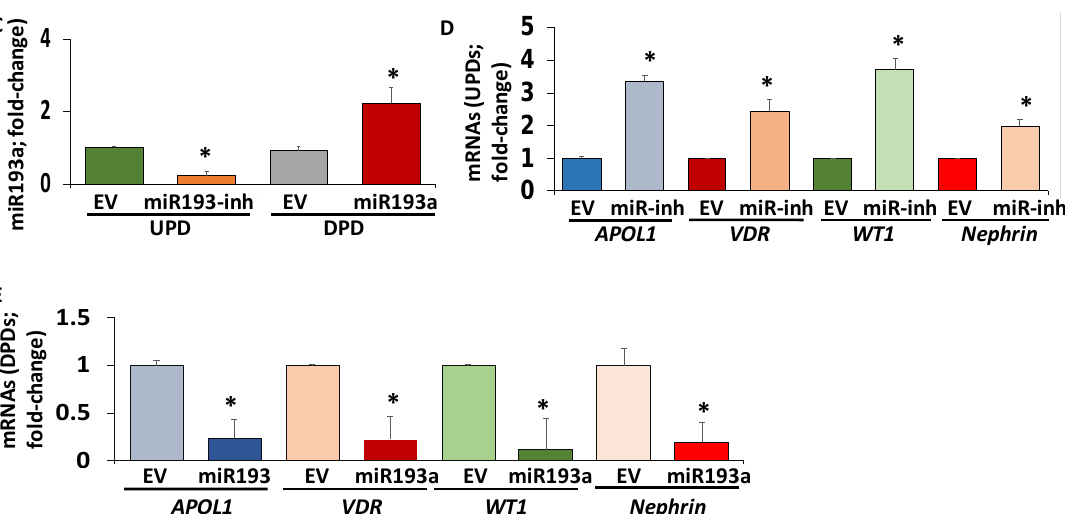
Figure 7. APOL1 3′ UTR and miR193a Secondary structures. ( A ) miR193a-5p structure conformation and hybrid structure conformations of APOL1 3′ UTR and miR193a-5p. The APOL1 3’ UTR structure conformation consists of secondary structure elements such as External loop, Helices, bulge loop, Interior loop, and Hairpin loops. i. The hybrid structure is showing miR193a-5p and APOL1 3′ UTR pairing with a 3′ overhang. ii. The hybrid structure conformation shows intensive pairing. ( B ) Tertiary structure of APOL1 3′ UTR and miR193a-5p (Magenta) complex. The miR193a-5p binding site on APOL1 3′ UTR is represented in Cyan. ( C ) UPDs were transfected with either control plasmid (empty vector, EV) or a specific inhibitor of miR193a (25 nM) (n = 3). In parallel sets of experiments, DPDs were transfected with either control plasmid (EV) or miR193a plasmid (50 nm) (n = 3). RNAs were assayed for miR193a. Cumulative data are displayed in bar graphs. * p < 0.0 compared to respective EV. ( D ) cDNAs from EV- and miR193a inhibitor-treated UPDs from 7C were amplified with specific primers for APOL1 , VDR , WT1 , and Nephrin (n = 3). Cumulative data are shown in a bar diagram. * p < 0.05 compared to respective EV. ( E ) cDNAs from EV and miR193a-transfected DPDs from 7C were amplified with specific primers for APOL1 , VDR , WT1 , and Nephrin (n = 3). Cumulative data are shown in bar graphs. * p < 0.05 compared with respective EV.